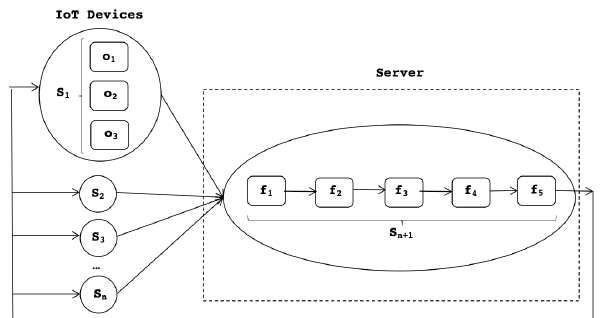
Figure 6. Expanded services